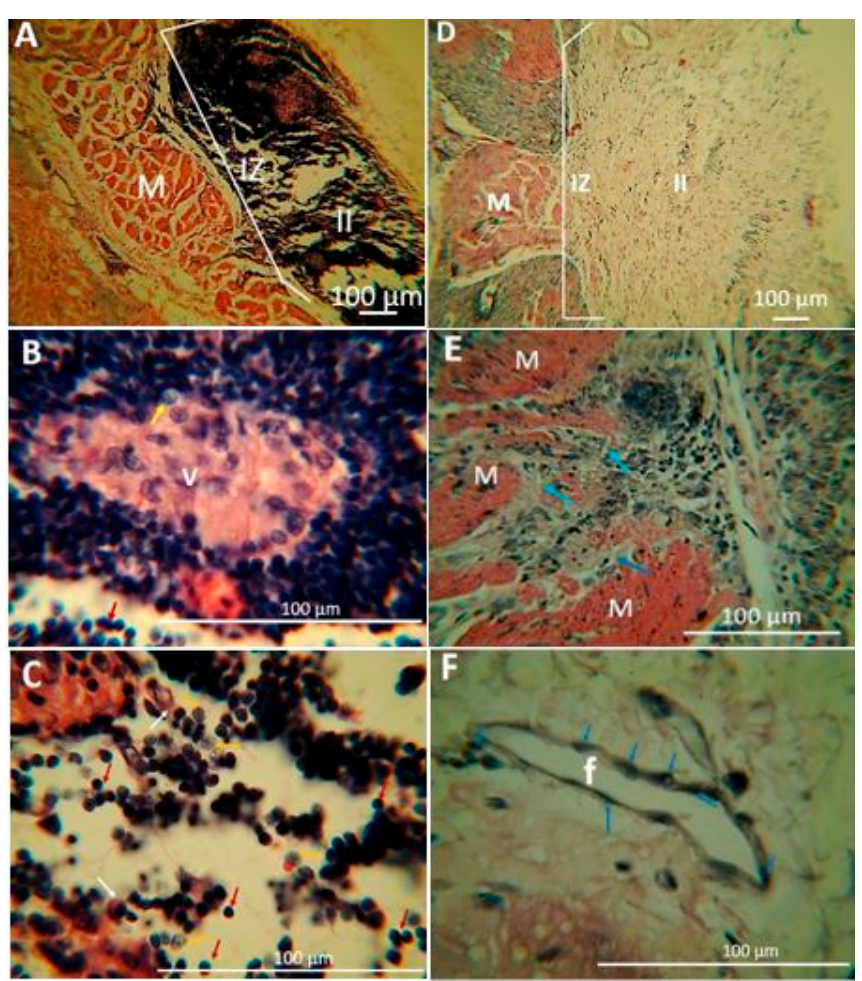
Figure 9. Nanocomposite F3 implanted in the subdermal area of Wistar rats at 30 and 90 days. ( A – C ) correspond to the nanocomposites after 30 days of implantation. ( D – F ) correspond to the nanocomposites after 90 days of implantation. ( A ) at 10×. ( B ) at 100×. ( C ) at 100×. ( D ) at 10×. ( E ) at 40× and ( F ) at 100×. IZ. Implantation area. M: Muscle. II: Inflammatory infiltrate. V: Blood vessel. Yellow arrows: implanted material. White arrow: Plasmocyte. Blue arrow: Histiocytes. Red arrow: Lymphocyte. f: Fiber. Hematoxylin–Eosin Technique (H&E).